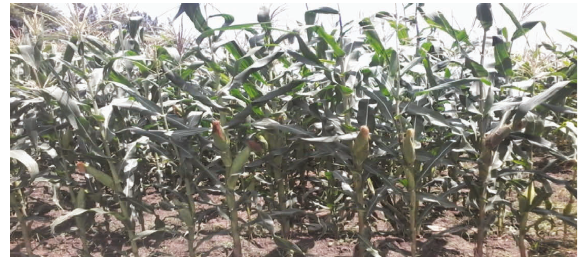
Figure 2: Field performance of OPV